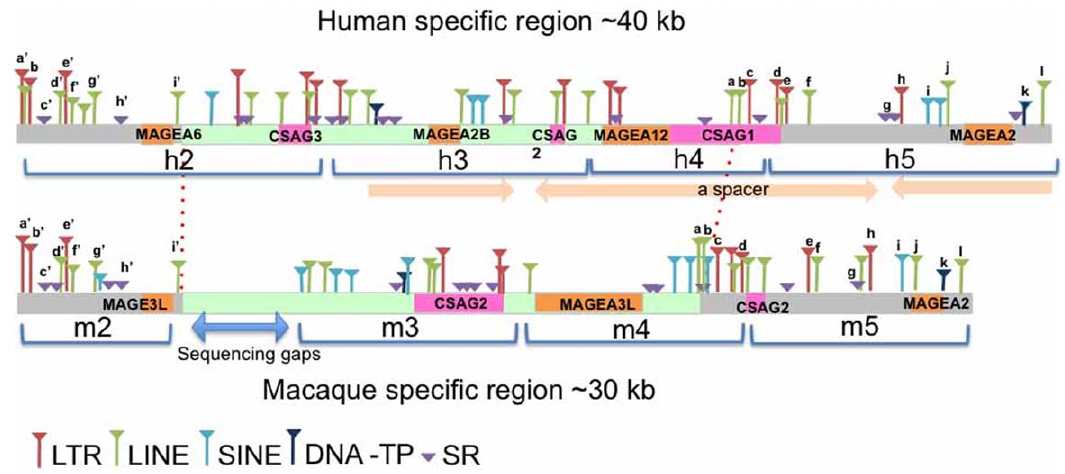
Figure 6. Maps of cladistic markers in humans and macaques. Colored triangles show interspersed elements ( LINEs or SINEs ), LTRs , DNA transposons ( DNA-TP ) or simple repeats ( SR ) found in the human or macaque genome, respectively. Brackets under each line indicate duplicated units. Light pink arrows indicate palindrome structure. The light blue arrow indicates sequencing gaps in macaques. Letters a to l and a 9 to i 9 on the triangles indicate orthologous insertion elements in the human and macaque genomes. The light green bar indicates a human- or macaque-specific region and dotted lines indicate the boundary between species-specific and orthologous regions.